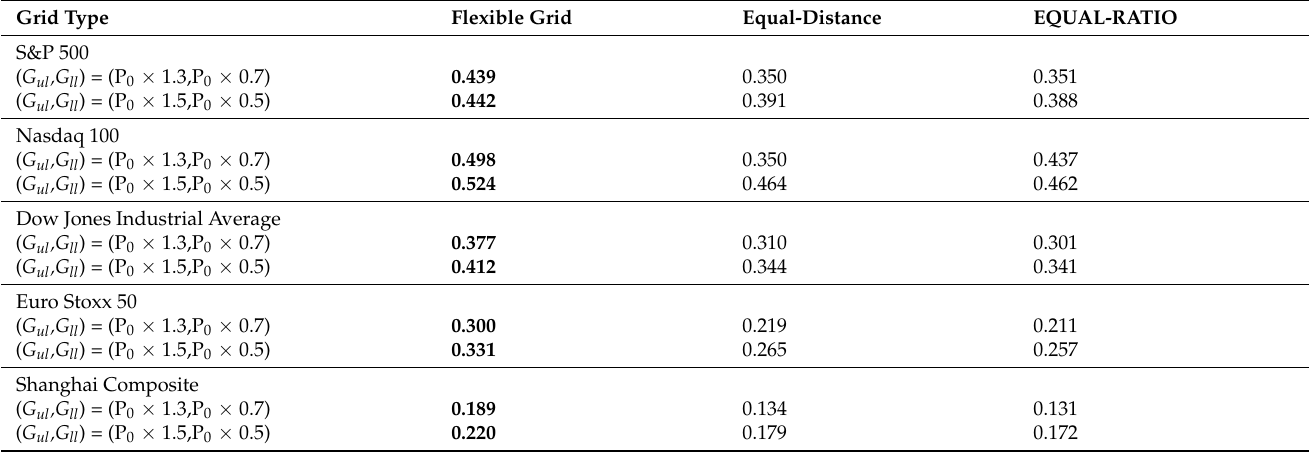
Table 11. Sharpe ratio obtained by flexible grid, equal-distance grid, and equal-ratio grid with SSO